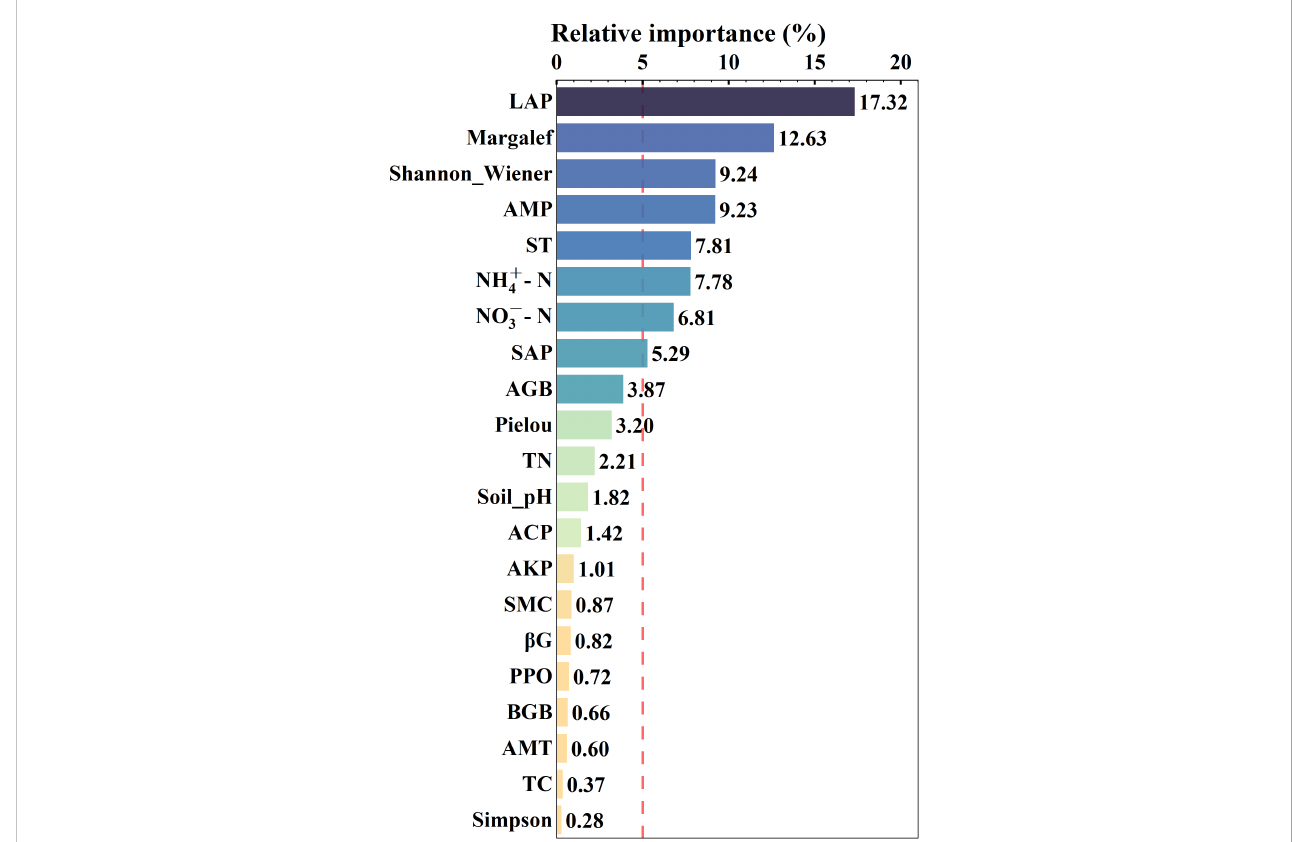
FIGURE 2 Results of boost regression tree analysis, screening factors by the dashed vertical red line (i.e., greater than 5%), the darker the color, the greater the relative importance. The environmental factors from top to bottom are LAP (soil leucine aminopeptidase, EC:3.4.11.1), Margalef (Margalef index), Shannon_Wiener (Shannon-Wiener index), AMP (annual mean precipitation), ST (soil temperature), NH 4+ -N (soil ammonium nitrogen), NO 3 − -N (soil nitrate nitrogen), SAP (soil available phosphorus content), AGB (aboveground biomass), Pielou (Pielou ’ s species evenness index), TN (soil total nitrogen content), Soil_pH, ACP (soil acid phosphatase, EC:3.1.3.2), AKP (soil alkaline phosphatase, EC:3.1.3.1), SMC (soil moisture content), b G (soil b -glucosidase, EC:3.2.1.21), PPO (soil polyphenol oxidase, EC:1.14.18.1), BGB (belowground biomass), AMT (annual mean temperature), TC (soil total carbon content), Simpson (Simpson ’ s diversity